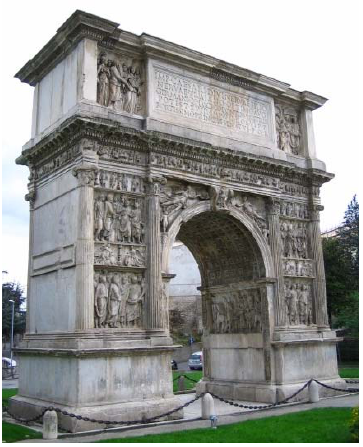
Figure 2. The view of the Trajan Arc With this process it is possible to achieve information both on the dynamic and static loads sources (seismic noise, anthropic noise, wind noise, etc.) which affect the monument and on the effects on its sculptures and structural elements, such as to provide reliable description and clarification of the existing damage patterns, like the ones in the